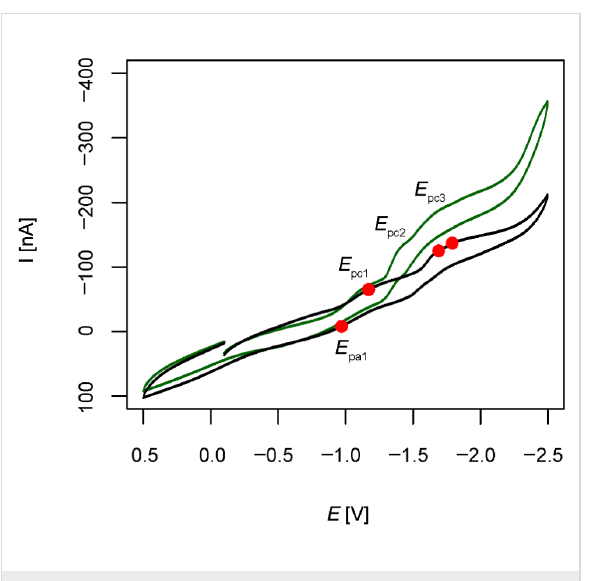
Figure 5: Cyclic voltammetry of 3 (1 mM, black) and of a mixture of 3 (1 mM) and methyl 2-iodo-5-nitrobenzoate (1 mM, green) in anhy- drous MeCN + 0.1 M Bu 4 NBF 4 , platinum electrode, scan rate = 0.1 V/s. For the first wave E pc1 = − 1.17 and E pa1 = − 0.97 were deter- mined, indicating a standard reduction potential E 0 1/2 = − 1.1 V vs the Ag/Ag + pair. These values are comparable to the ones